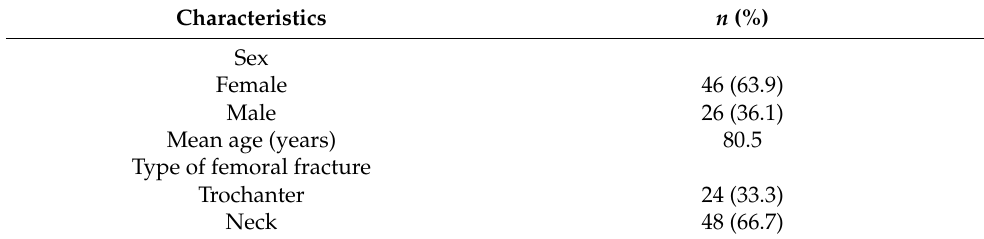
Table 2. Patient demographics.